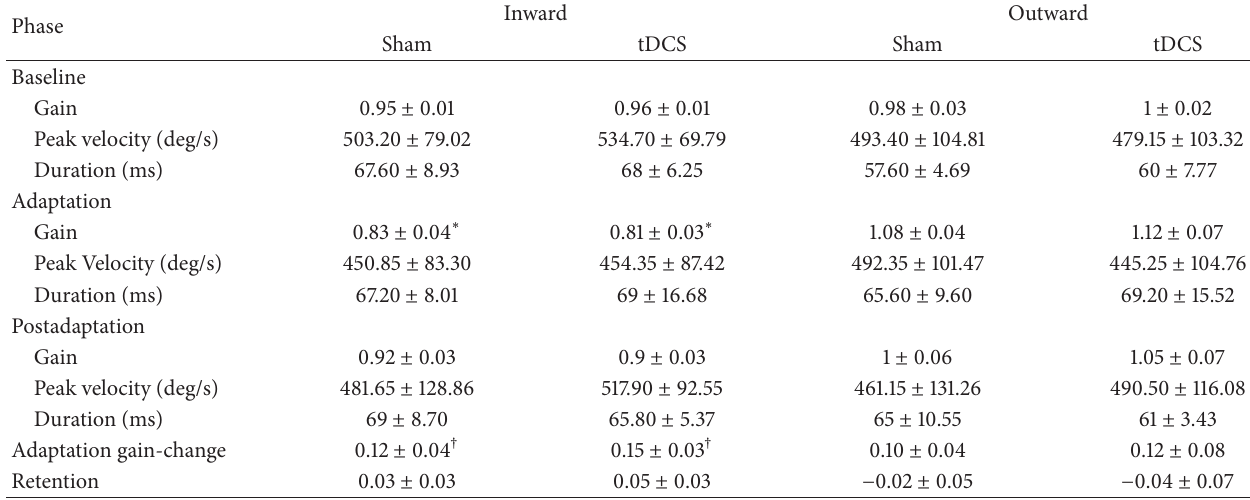
Table 1: Saccadic gains, kinematics, adaptation gain-change, and retention. Gains, saccade kinematics (peak velocity and duration) measured during the three phases for inward and outward adaptation in the two conditions. Inward and outward adaptation gain-change for the two conditions shows the difference between preadaptation and adaptation phases. Adaptation phase values are the last ten trials (adaptation gain). Peak velocity in deg/s and Duration in